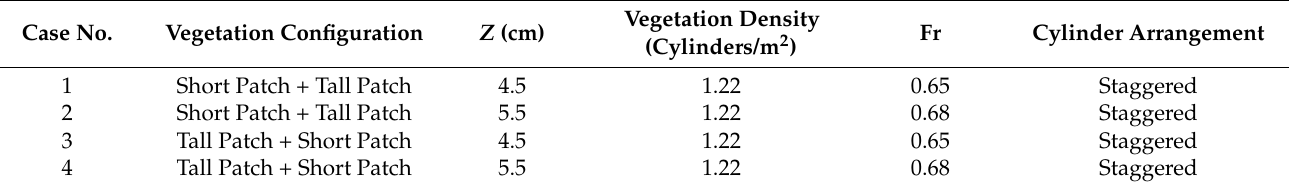
Figure 4. Spacing between cylinders. Table 1. Hydraulic conditions of the numerical Table 1. Hydraulic conditions of the numerical model.